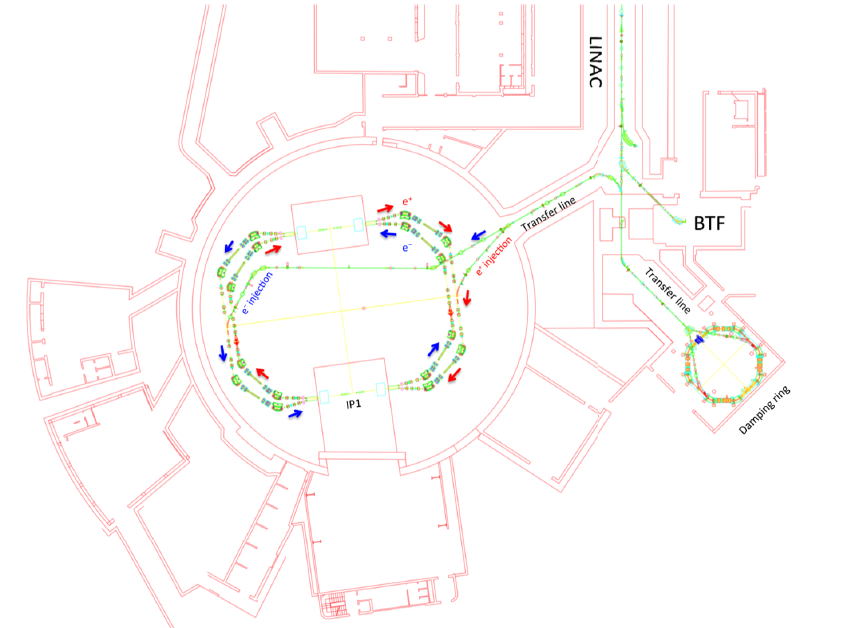
Figure 4. DA Φ NE accelerator complex in Frascati, showing the two positron and electron intersecting